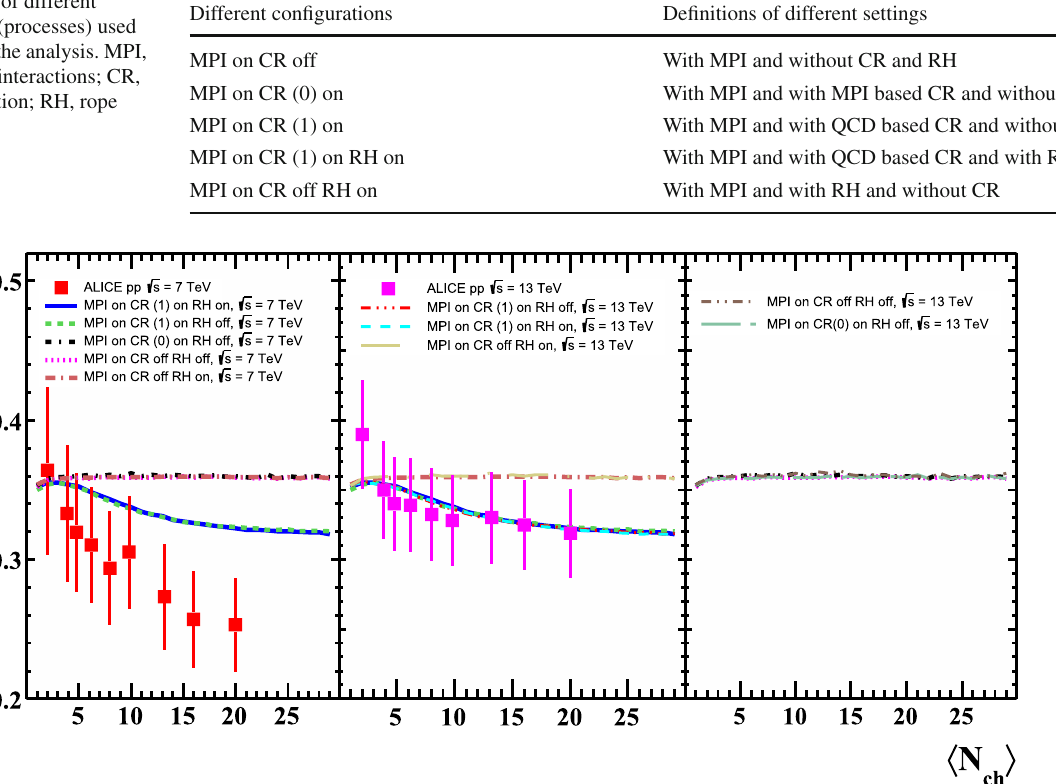
CR(0) and CR(1) with RH. (Right panel) Comparison of ratios for p–p √ s = 7 TeV and 13 TeV for two other modes, namely collisions at CR-off and CR(0) without RH. The solid squares show the multiplicity √ s = 7 TeV and 13 TeV as dependence of K ∗ 0 / K for p–p collisions at obtained by the ALICE experiment